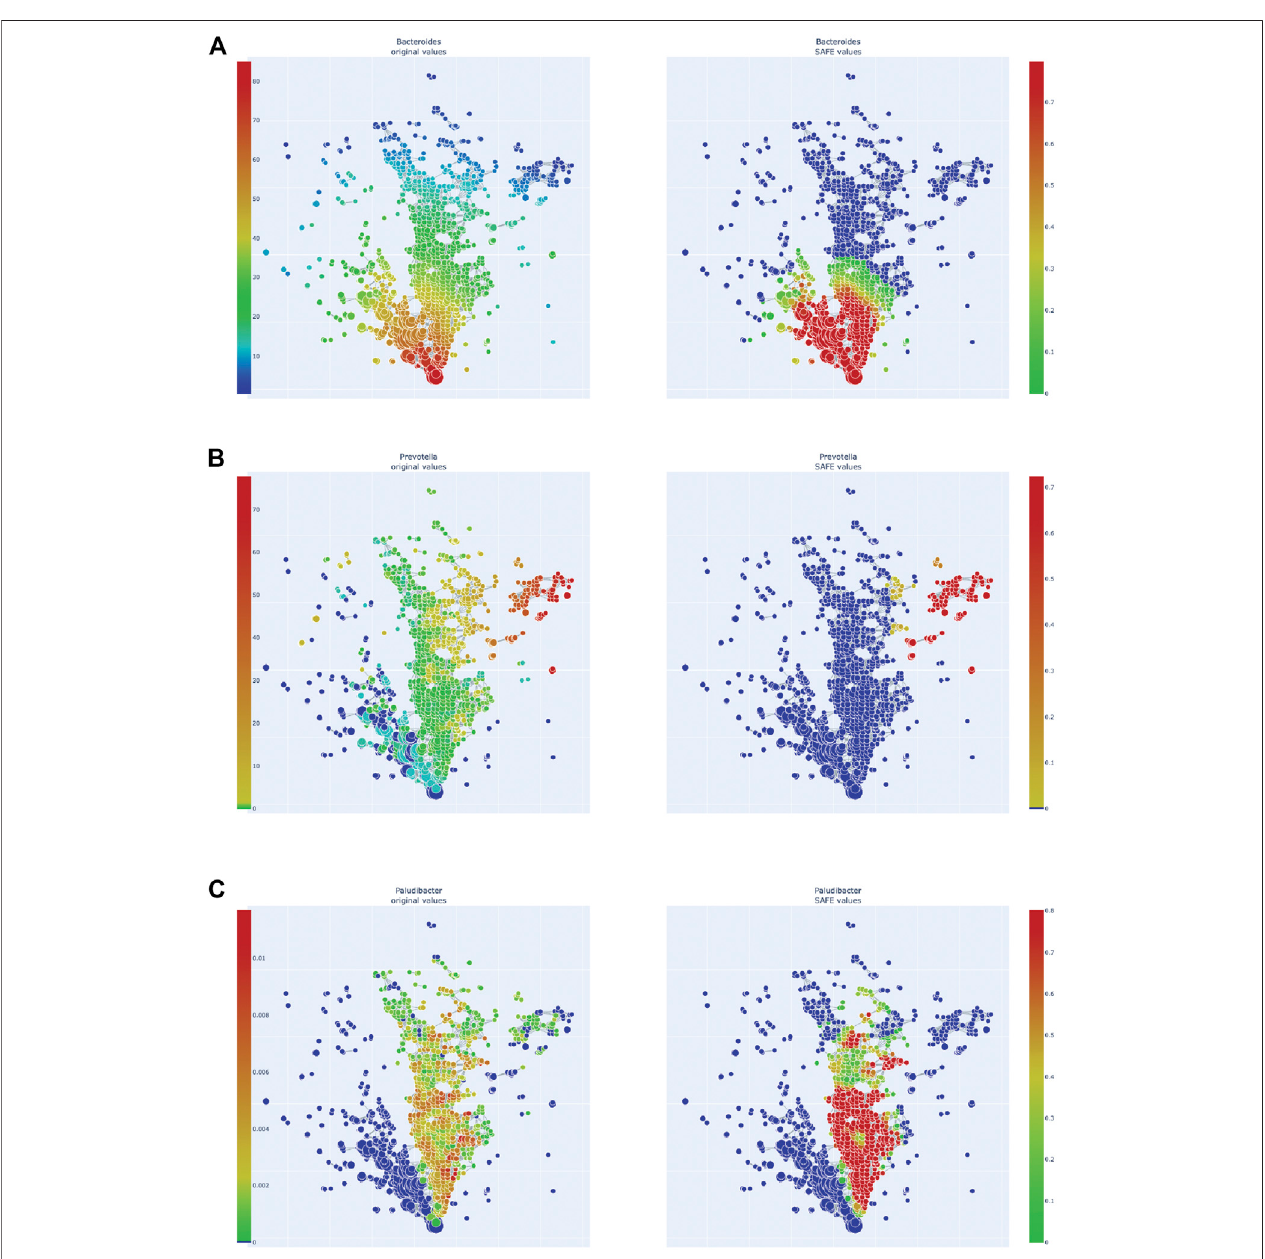
FIGURE 4 | Enrichment heatmaps of three Bacteroidetes genera, absolute abundance across the network on the left, enrichment on the right. (A) Bacteroides . (B) Prevotella . (C) Paludibacter